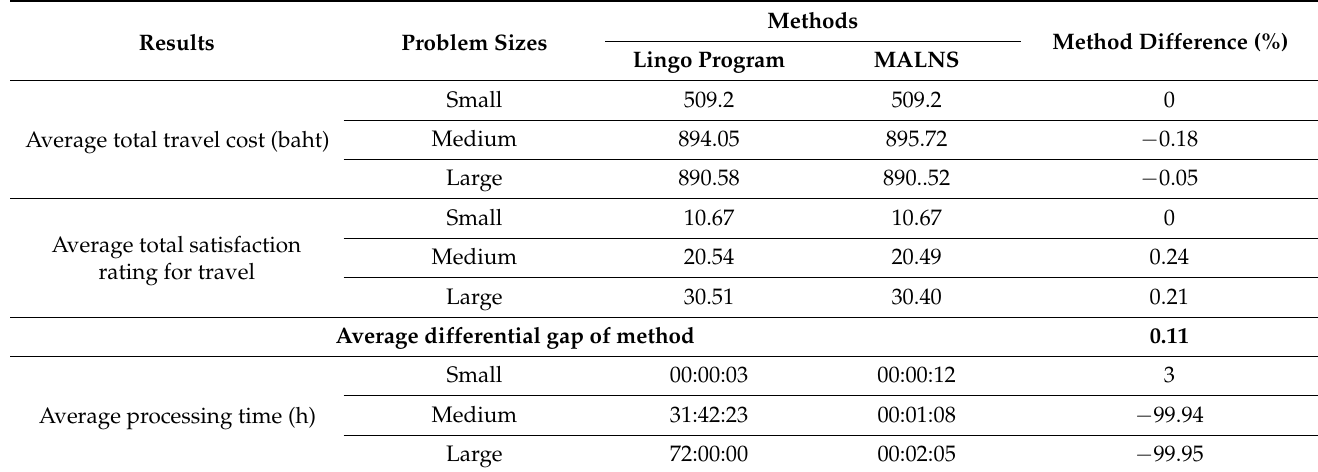
Table 3. Comparison of the results for the Lingo program and MALNS